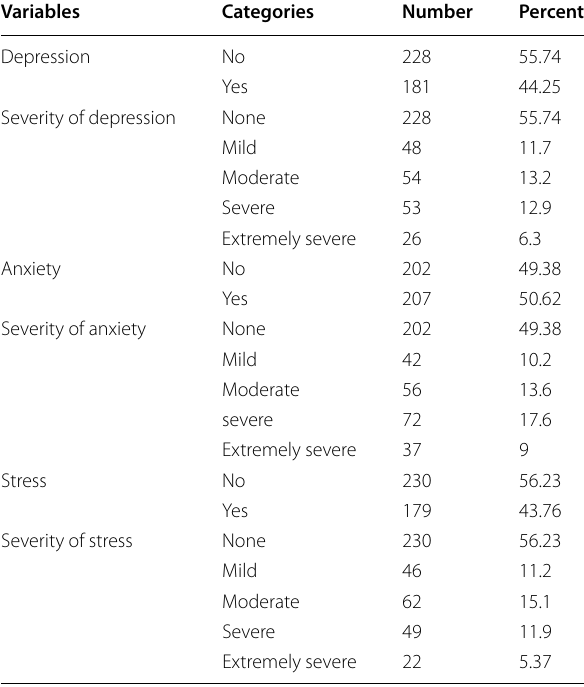
Table 2 Psychological characteristics of the